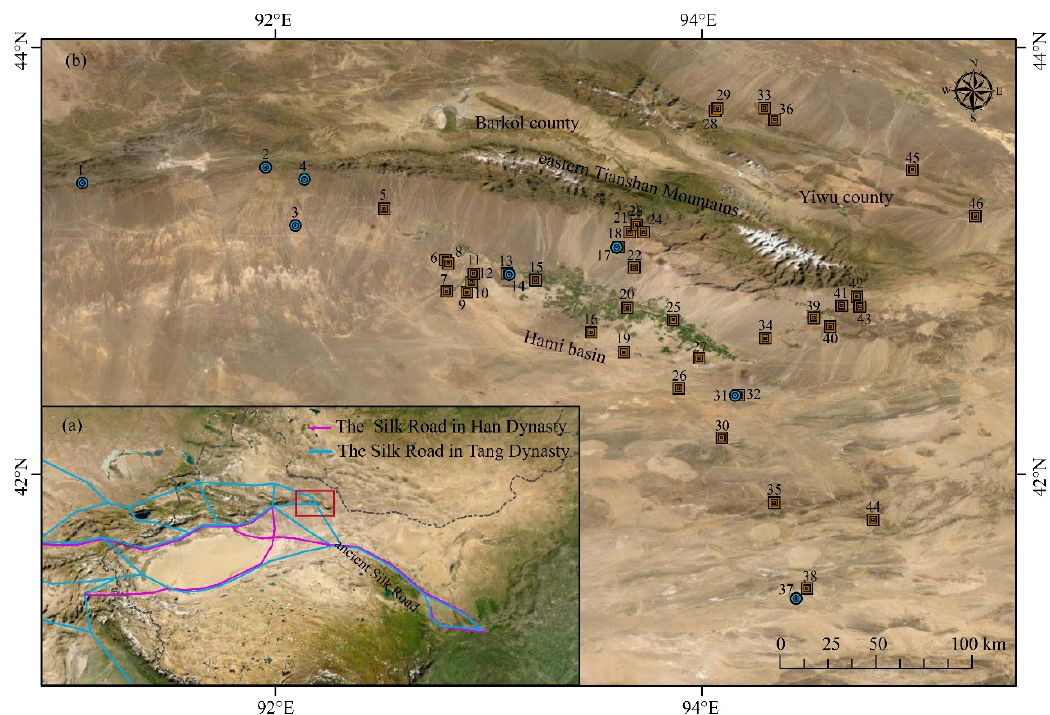
Figure 1. The spatial distribution of beacon and post sites in the Hami area. The pink and blue lines represent the ancient Silk Road ( a ). Brown boxes represent beacon towers and blue circles represent dak sites ( b ). Note: (1) Xiyanchi; (2) Cheguluquan; (3) Laoyiwanquan; (4) Yiwanquan; (5) Shadunzi;